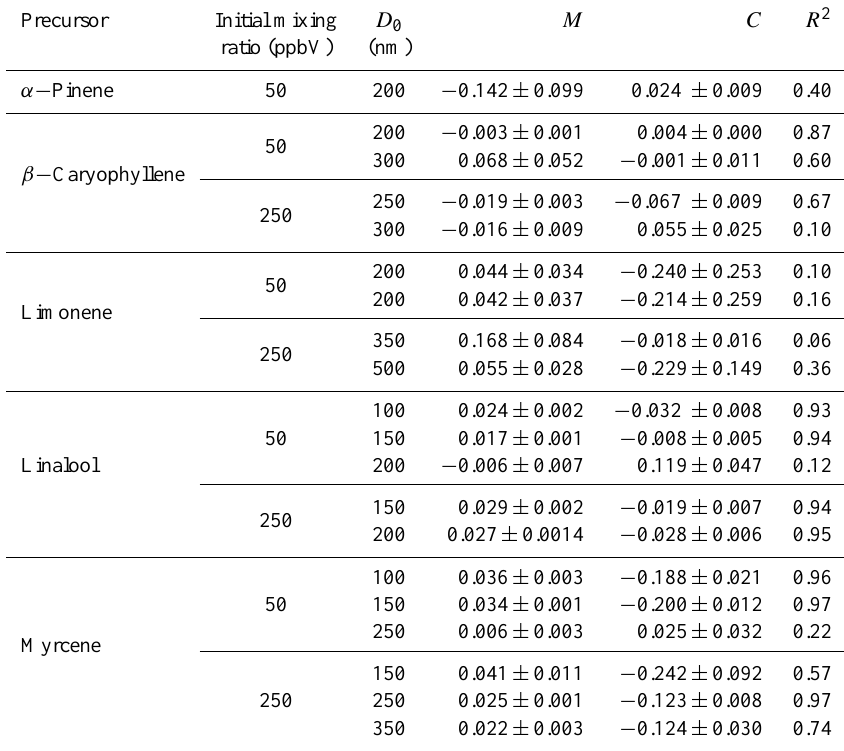
Table 5. Linear fit parameters and coefficient of determination ( R 2 ) of the relationship between the hygroscopicity (represented by κ HTDMA ) of particles of a single size and the degree of particle oxidation (represented by f 44 )